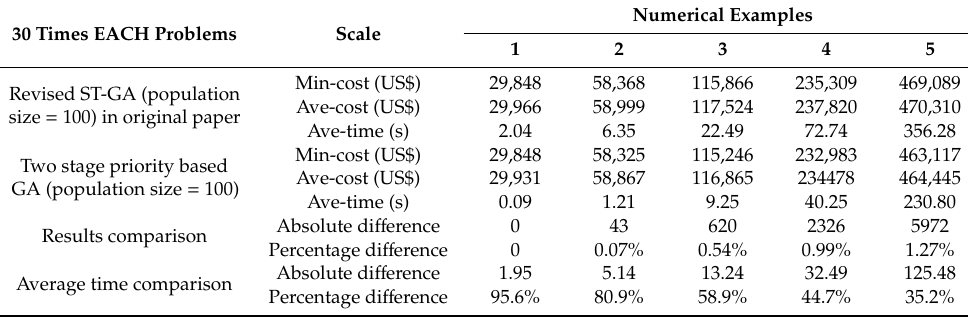
Table 3. Comparison of the proposed approach and the spanning tree based GA.